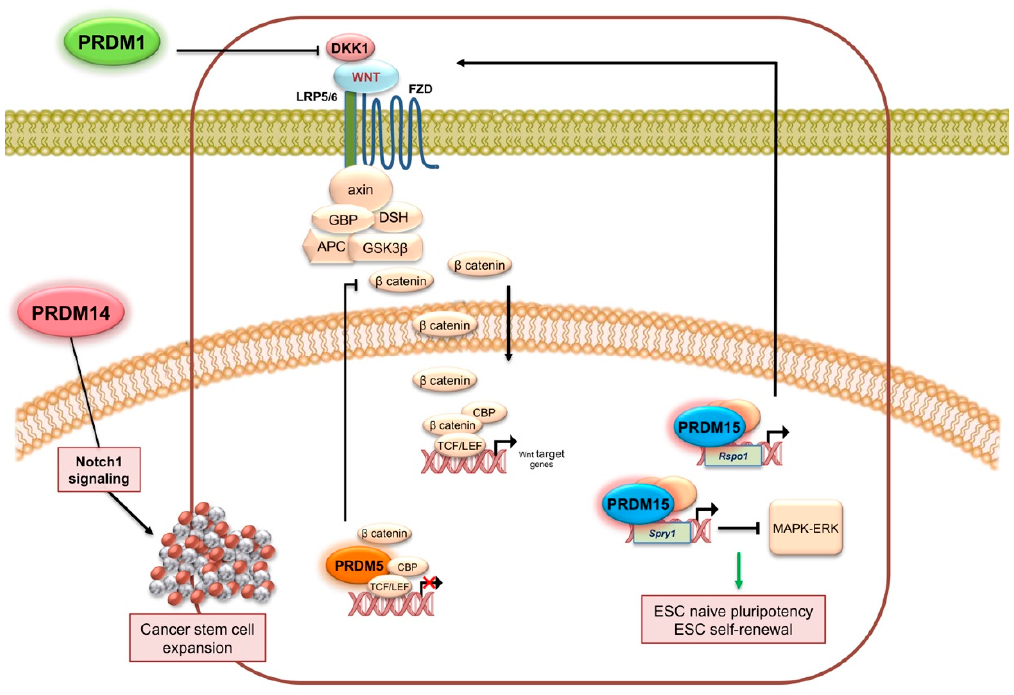
Figure 5. PRDM activity in cancer stemness. The figure summarizes the mechanisms regulated by some PRDMs and possibly involved in cancer stemness (see text for detailed description).